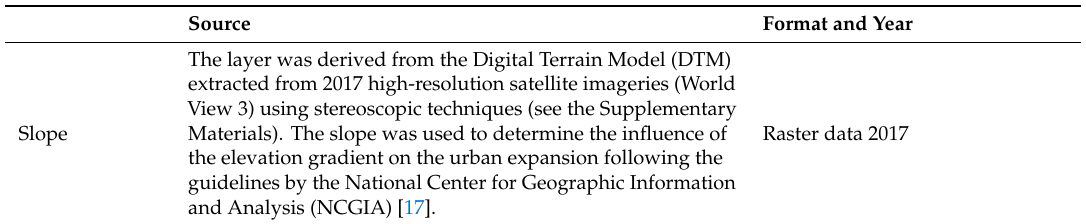
Table 1. Input datasets for the SLEUTH (slope, land use, exclusion, urban extent, transportation, and hill shade) model.